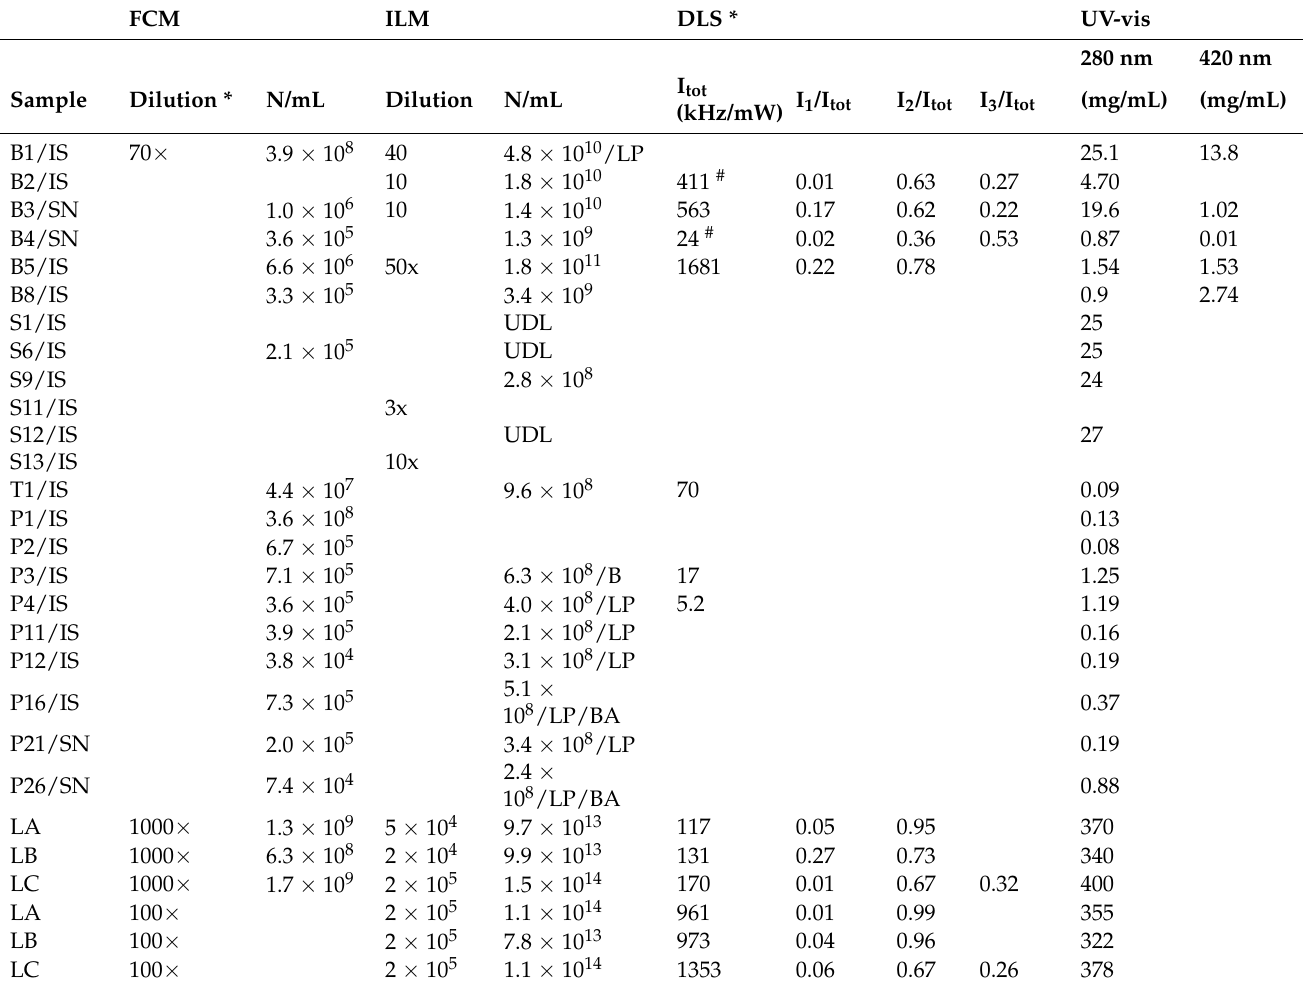
Table 1. Amount of material in samples from blood (B), spruce homogenate (S), flagellae of Tetraselmis chuii (T), conditioned culture media of Phaeodactylum tricornutum (P), and liposomes (L) as detected by four methods (FCM, ILM, DLS, and